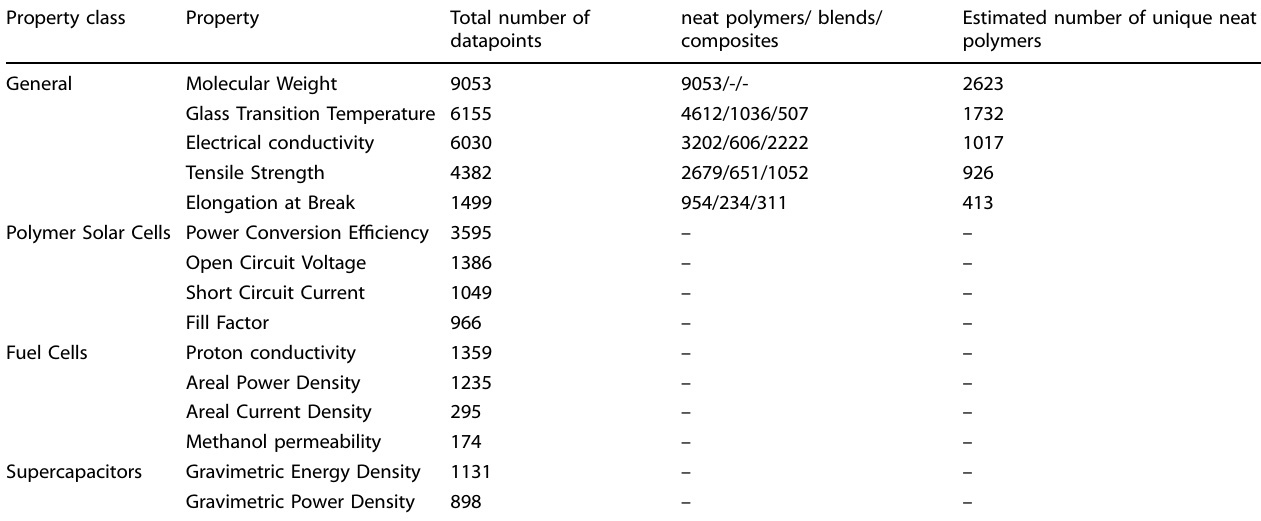
Table 4. Number of material property records extracted for several key polymer properties and fi gures of merit for certain applications. Property